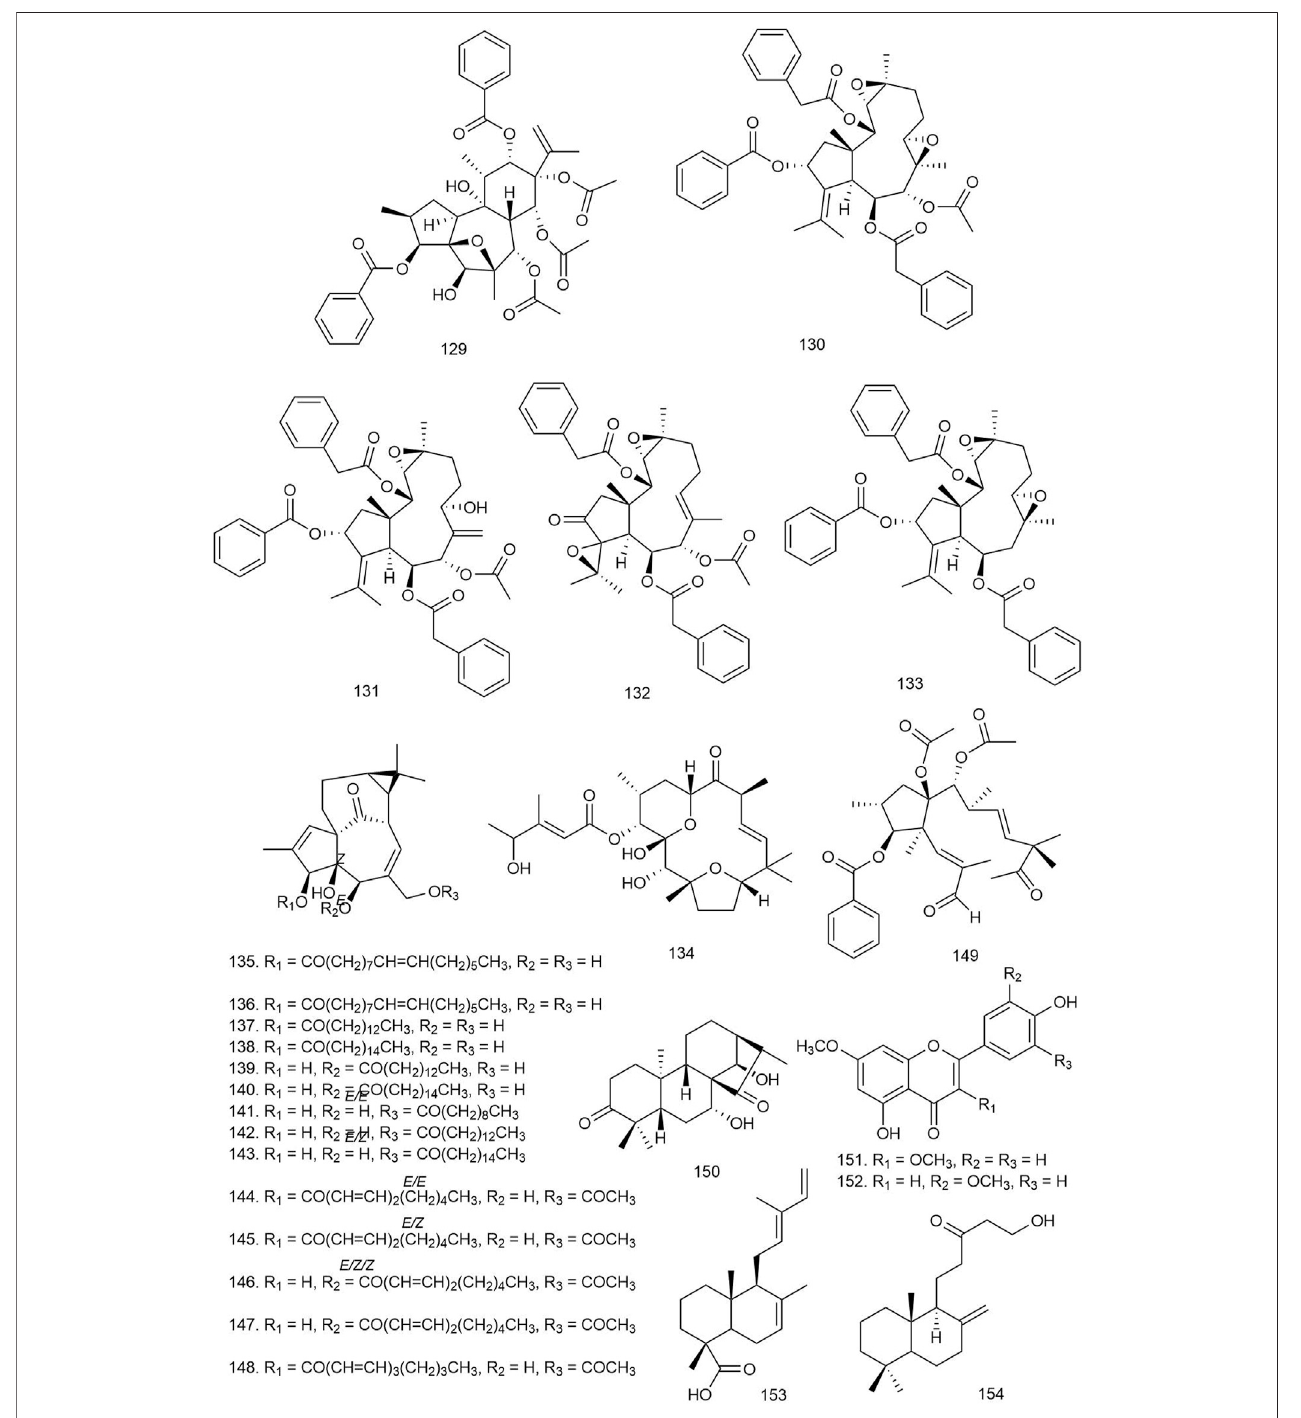
FIGURE 8 | Structures of daphane, dolabellane, and fl exibilene diterpenoids with signi fi cant antiviral activity.